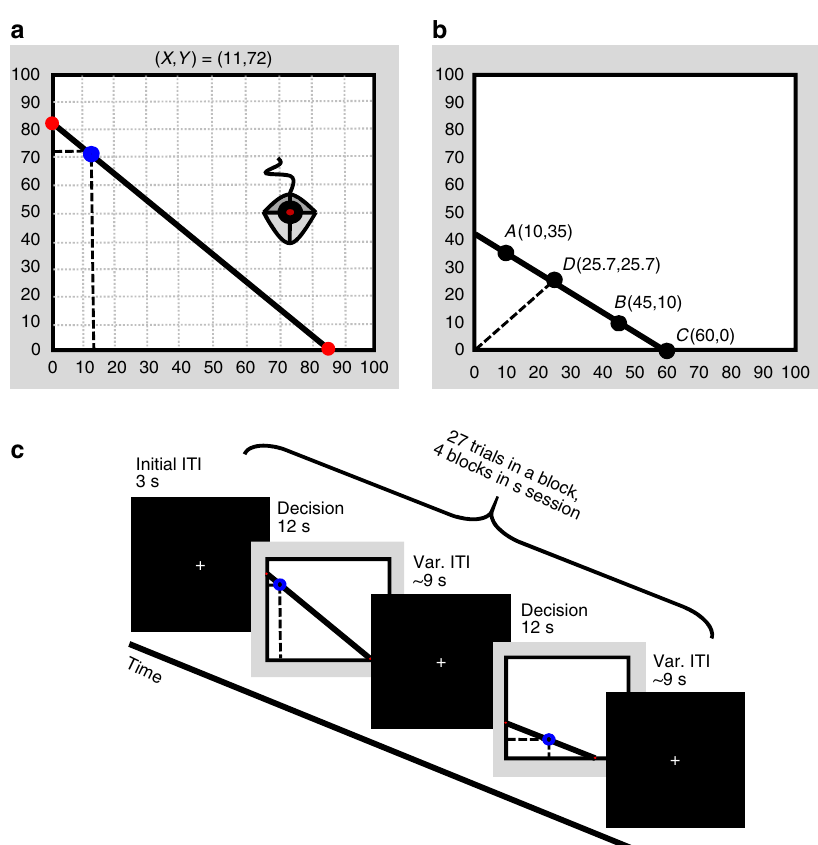
Fig. 2 Experimental task (following Choi et al. 13 ). a A Trial: Subjects were presented a visualization of a budget line with 50/50 lotteries between two accounts, labeled X and Y . Each point on the budget line represents a different lottery between the X and Y accounts. Subjects used a trackball to choose their preferred lottery (a bundle of the X and Y accounts) out of all possible lotteries along the line. For example, as depicted in Fig. 2a, the bundle (11,72) corresponds to a lottery with a 50% chance to win 11 tokens (account X ), and a 50% chance to win 72 tokens (account Y ), where 1 token equals 5 NIS (~$1.5). We varied and randomized the budget lines (slopes and endowments) across trials and subjects. At the end of the experiment, one trial was randomly selected as well as one of the accounts. The subject received the tokens she had allocated to the selected account in the selected trial. b Behavioral example: Given this budget line, the subject could choose A (10,35) with a 50% chance of winning 10 tokens (account X ) and 50% chance